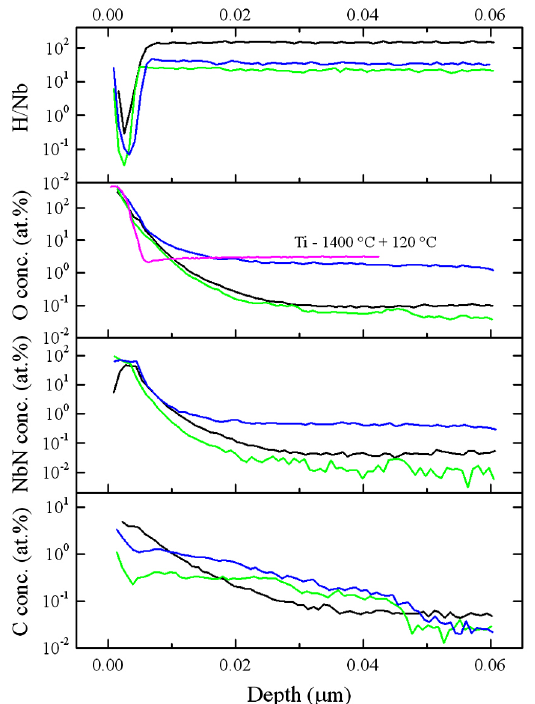
FIG. 15. High-resolution depth profiles of H/Nb, oxygen, NbN, and carbon measured in a reference, non-heat-treated, sample L11 (black line), sample L48 heat treated at 1200 (cid:1) C (green line), and sample L51 heat treated at 1400 (cid:1) C and 120 (cid:1) C (blue line). Also shown in the second panel is the Ti depth profile in sample L51 (magenta line).